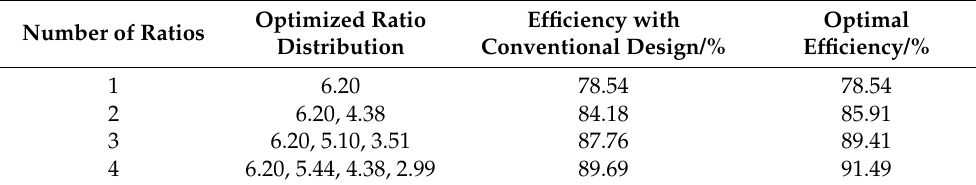
Table 3. Transformer ratio design strategy and optimal